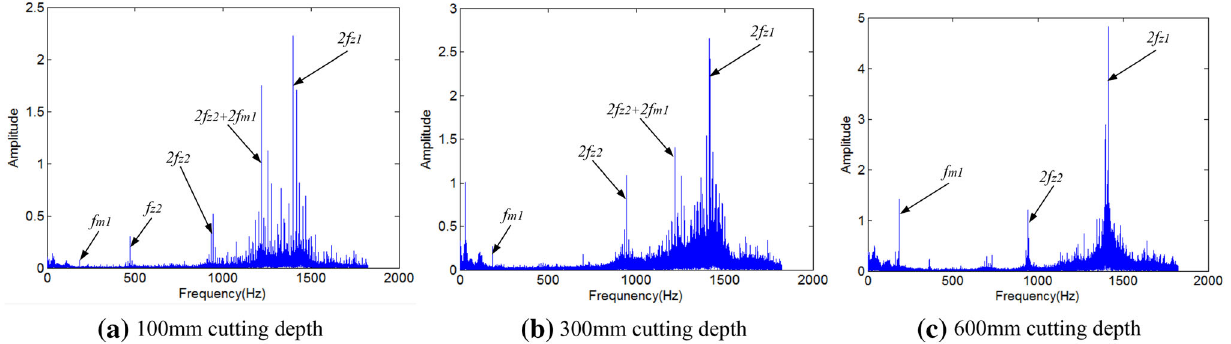
Fig. 12 Frequency coupling of planetary